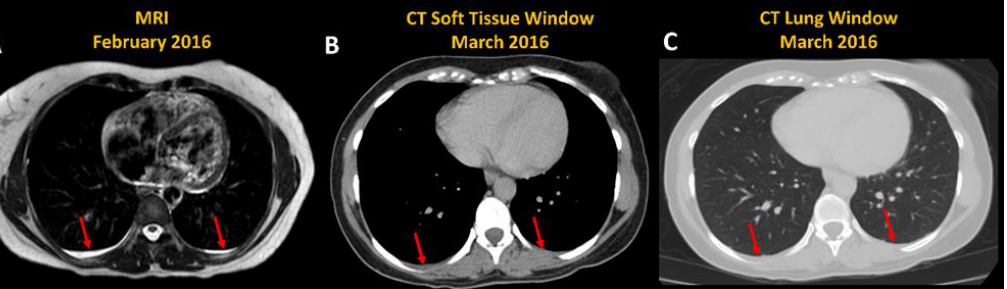
Figure 4. Pleural effusion (red arrows) seen on the same patient on ( A ) axial T2-weighted MRI and 1 month later on CT ( B ) soft tissue and ( C ) lung windows. Note that CT does not show the pleural fluid as well even though the amount of fluid is unchanged.